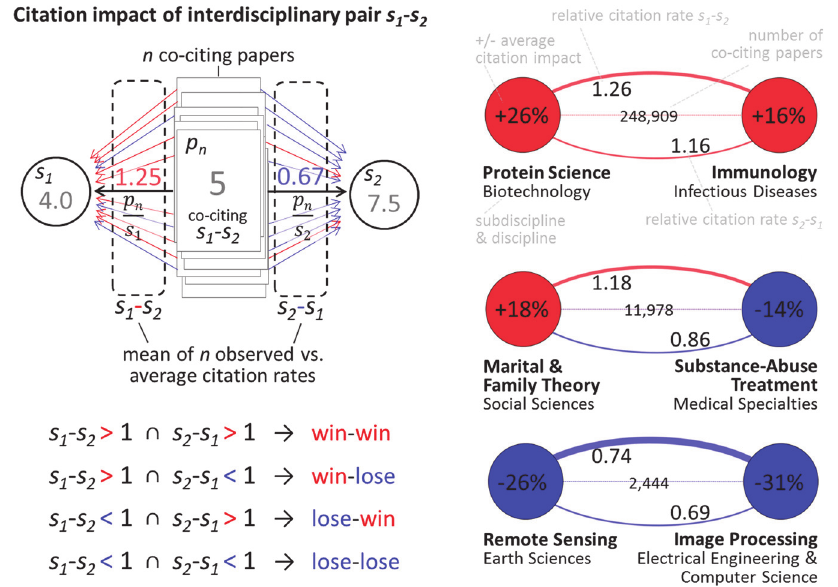
Fig 6. Schematic representation of the calculation and definition of citation impact of interdisciplinarity pairs.